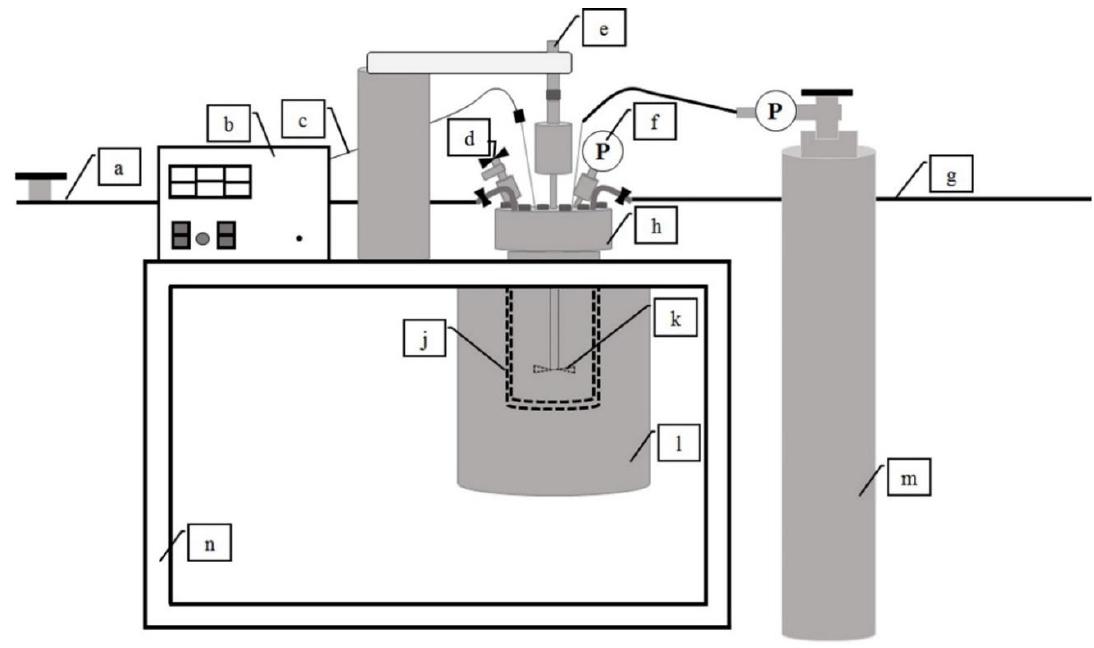
Figure 1. Experimental set-up: ( a ) Cooling water in, ( b ) PID controller, ( c ) Thermocouple, ( d ) Purge valve, ( e ) Stirrer Motor, ( f ) Pressure gauge, ( g ) Cooling water out, ( h ) Reactor lid, ( j ) Reactor vessel, ( k ) Stirrer, ( l ) Heating jacket, ( m ) Nitrogen cylinder, and ( n ) Reactor